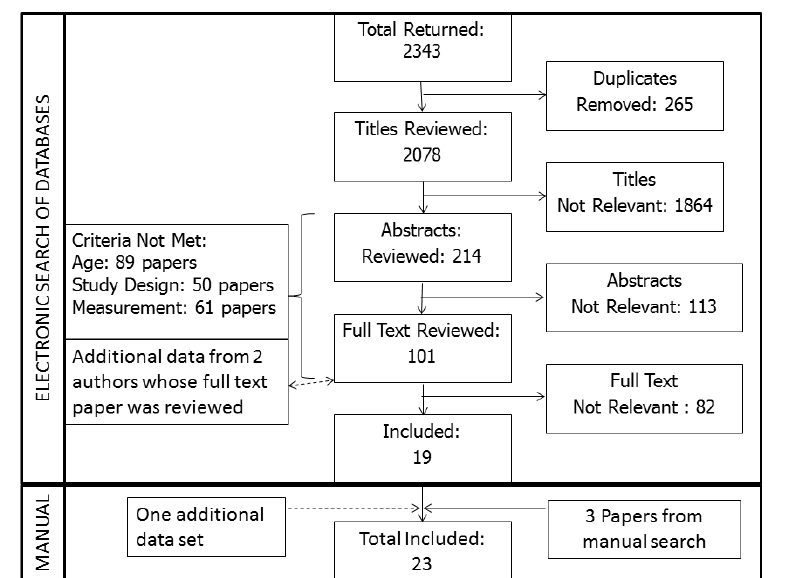
Figure 1. Prisma diagram of the systematic process of identification of relevant